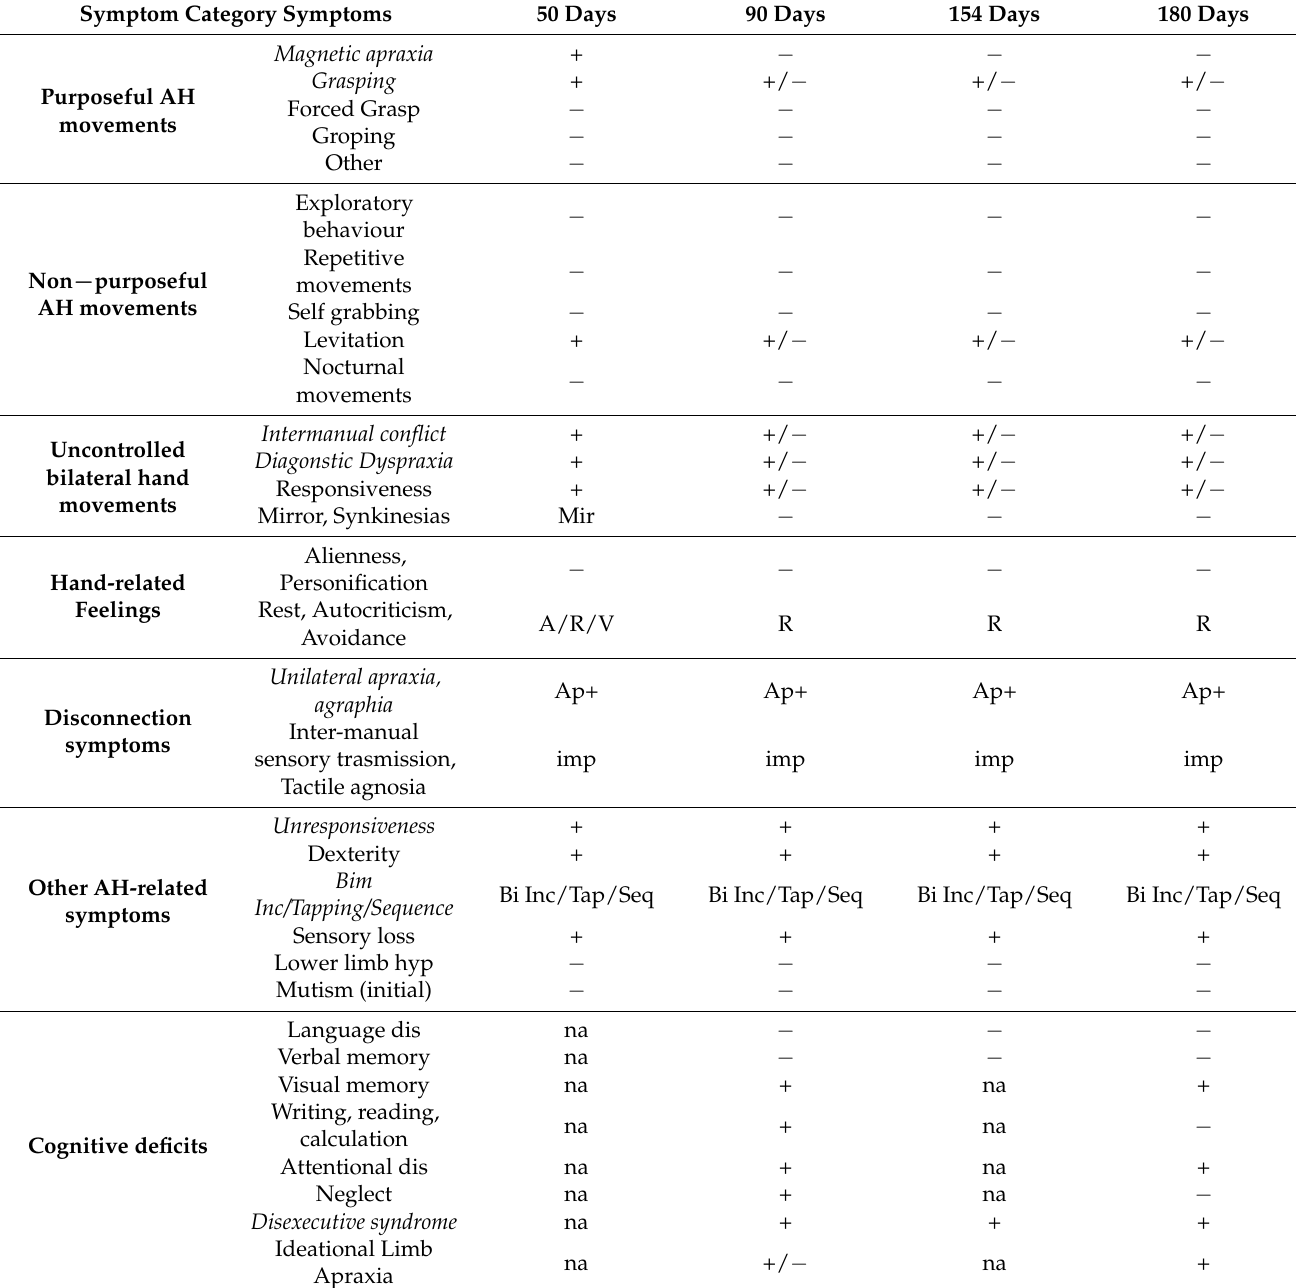
Table 1. BG’s AHS symptoms as assessed in the repeated sections of